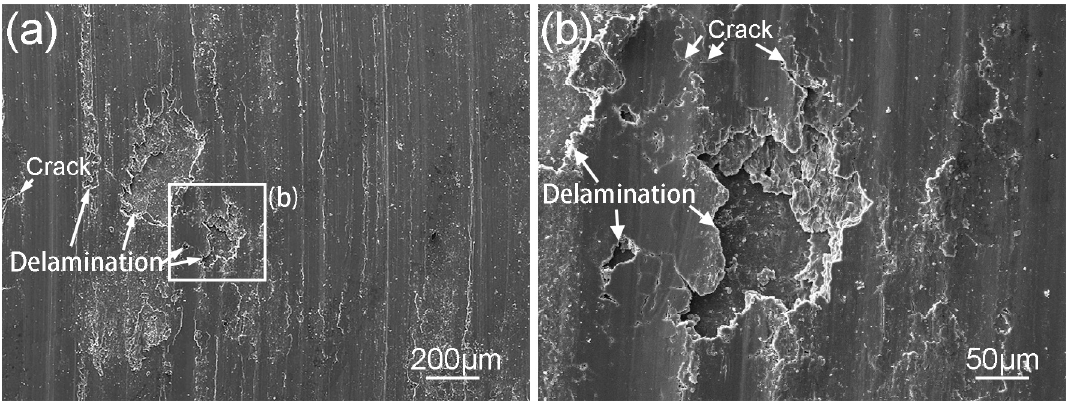
Figure 9. ( a ) Delamination mode of wear for surfacing AZ91 alloy tested at 1.25 m/s and 20 N and ( b ) the corresponding enlarged view of ( a ).